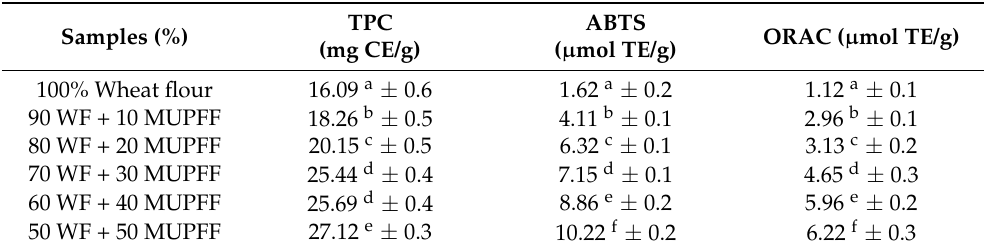
Table 3. Total phenolic content and antioxidant properties of composite flour from wheat flour and unripe pawpaw fruit